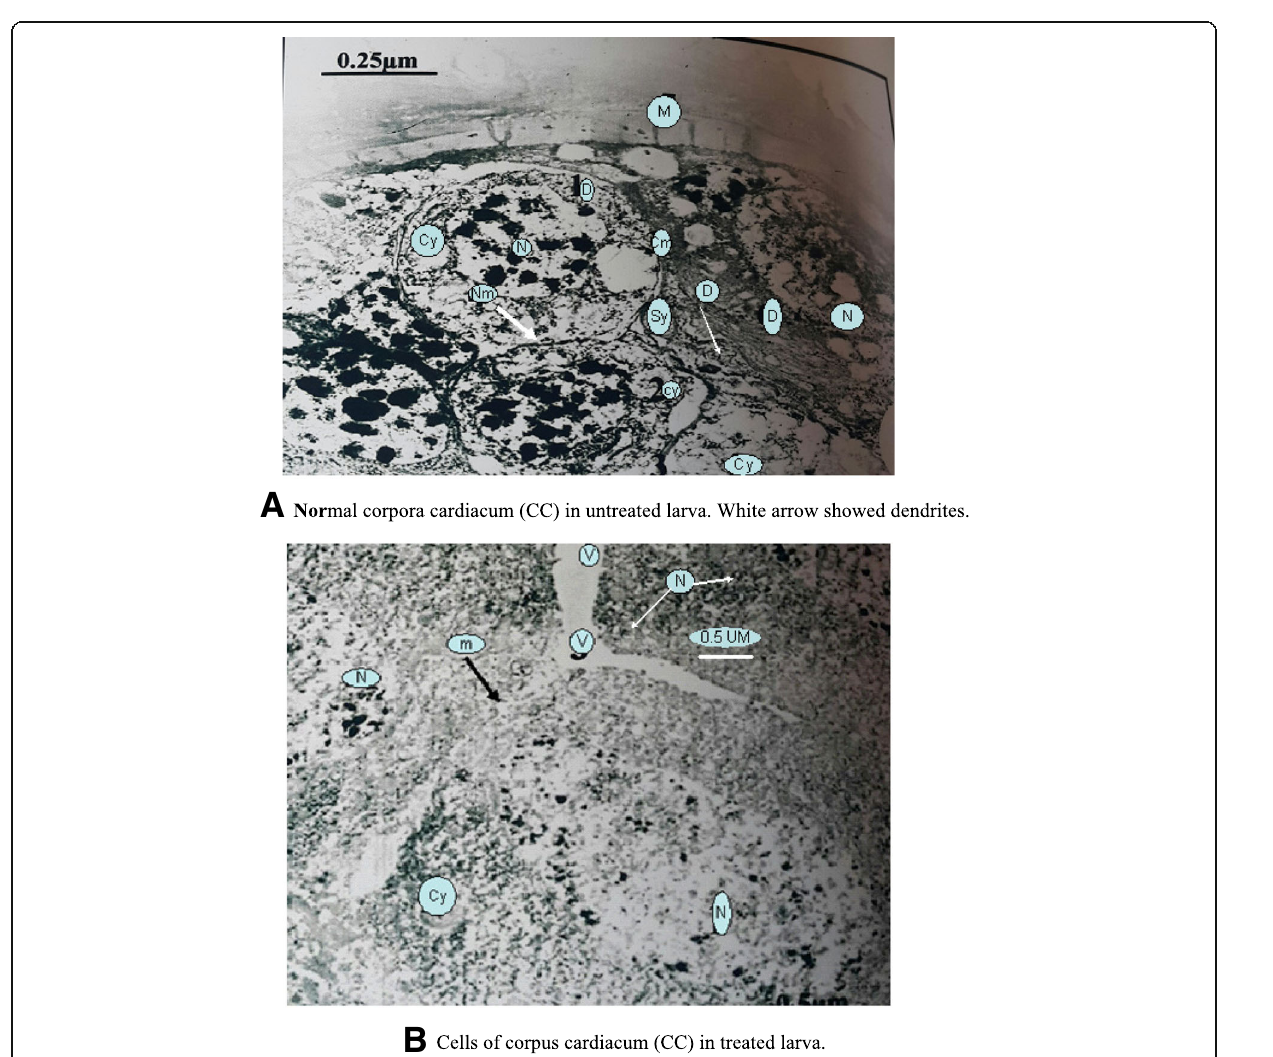
Fig. 7 a Normal corpora cardiacum (CC) in untreated larva. White arrow showed the dendrites. b Cells of corpus cardiacum (CC) in treated larva. Sections in different tissues of the endocrine system of the potato tuber moth Phthorimaea operculalla larva detected under electron microscope observation . a The normal untreated tissues. b The treated tissues of larva reared on potato tubers covered with talcum powder containing 0.5% each of basil extract + B.t + GV and 25 g/1 kg tuber. Abbreviations: NC neurosecretory cells, CC corpus cardiacum, CA corpus allatum, PRO prothoracic gland, N nucleus, D dendrites, sy synaptic vesicles, V vacuoles, F fat droplets, M cell membrane, Nm nuclear membrane, Cy